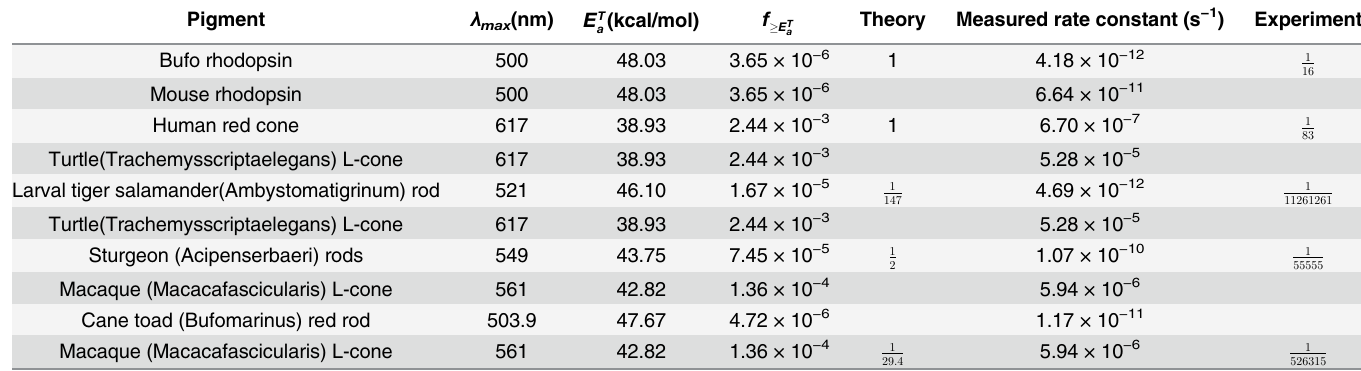
Table 4. Comparison between theoretical predictions offered by Luo et al [2] (i.e. , labeled as “ Experiment ” ). Even for similar λ max values of rods (Bufo and mouse) and cones (human and turtle), 16 constants of visual pigments (i.e. k 1 k 2 and 83 fold difference appeared respectively. For other comparisons between rods and cones the differences are very large numbers which indicates that predicted and measured rate constants are not comparable.